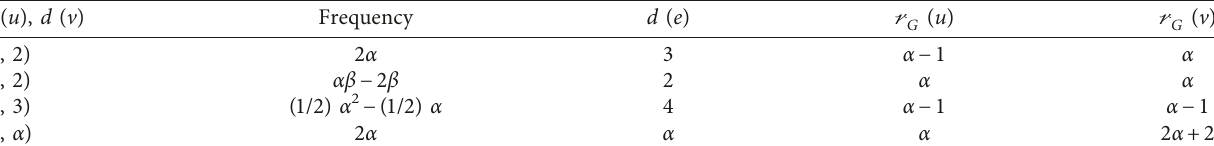
Table 3: Degree-based partition of